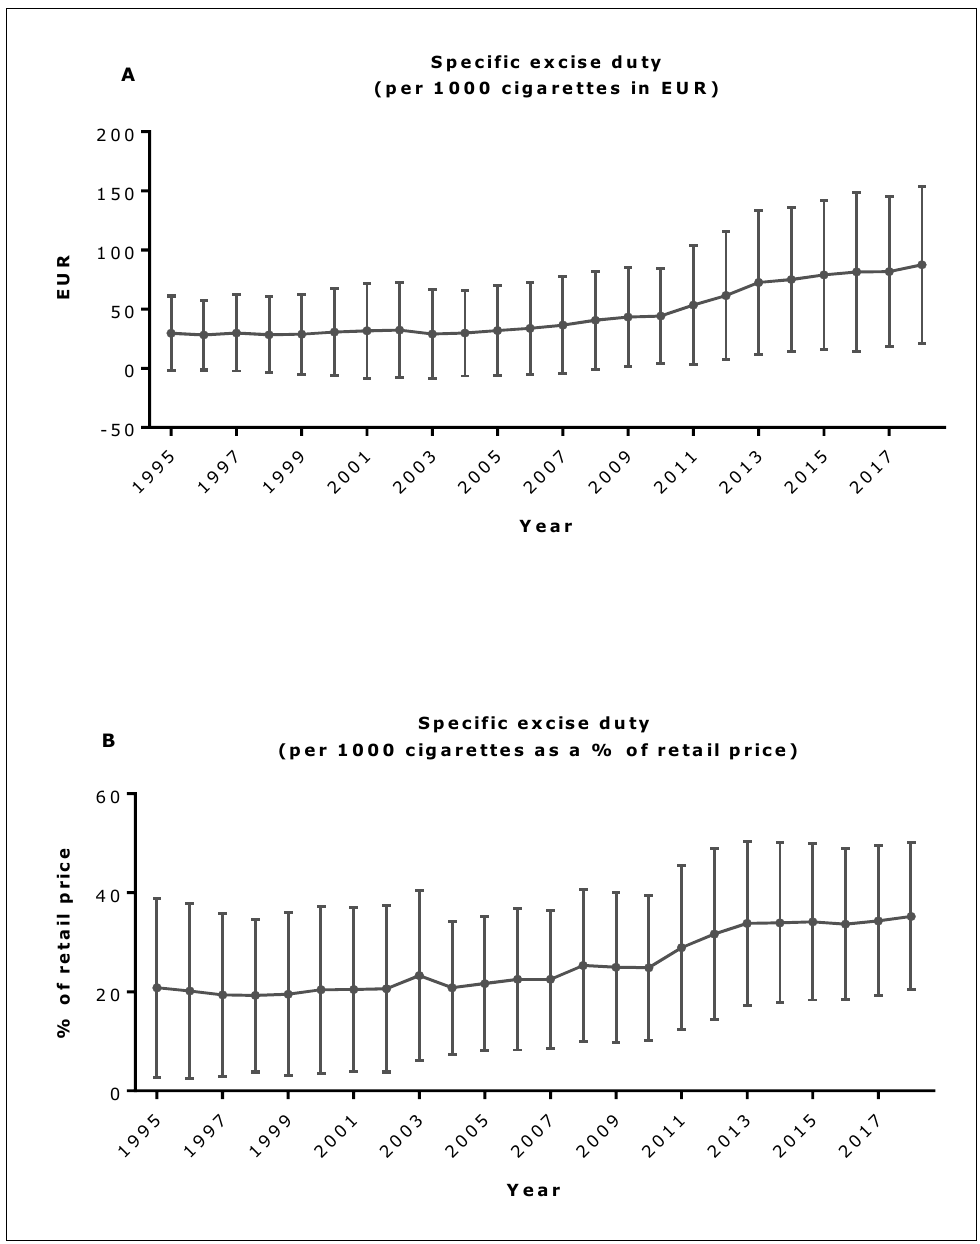
Error bars represent standard deviation. Figure 1. Mean EU specific excise duty in EUR ( A ) and as a percent of retail price ( B ).